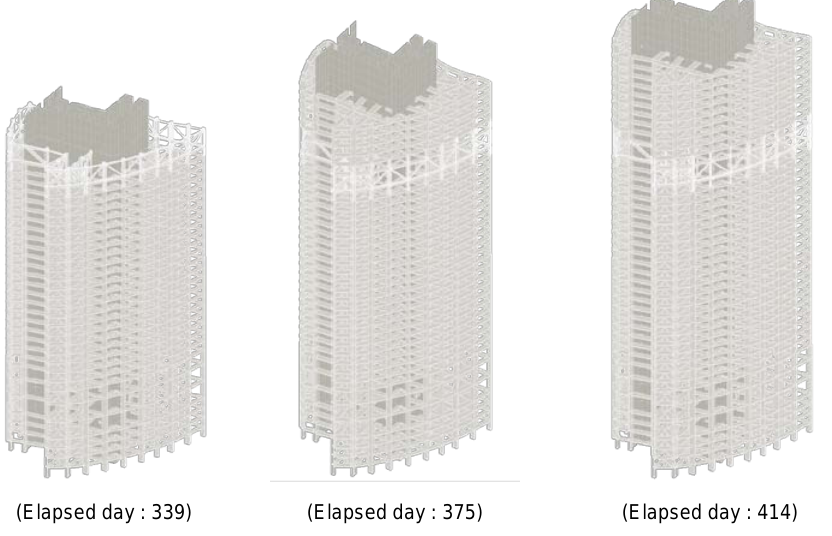
Figure 13. Simulation models of tower 2 for different days.